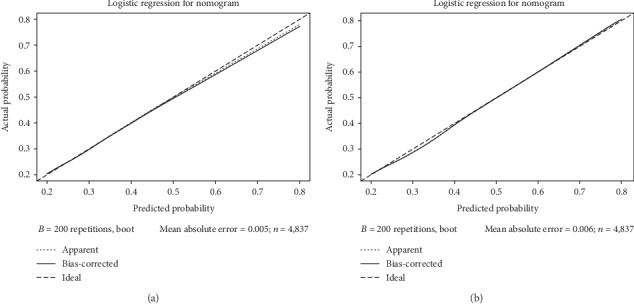
The calibration curves for predictions of synchronous metastatic GISTs (a) in the training cohort and (b) in the validation cohort.